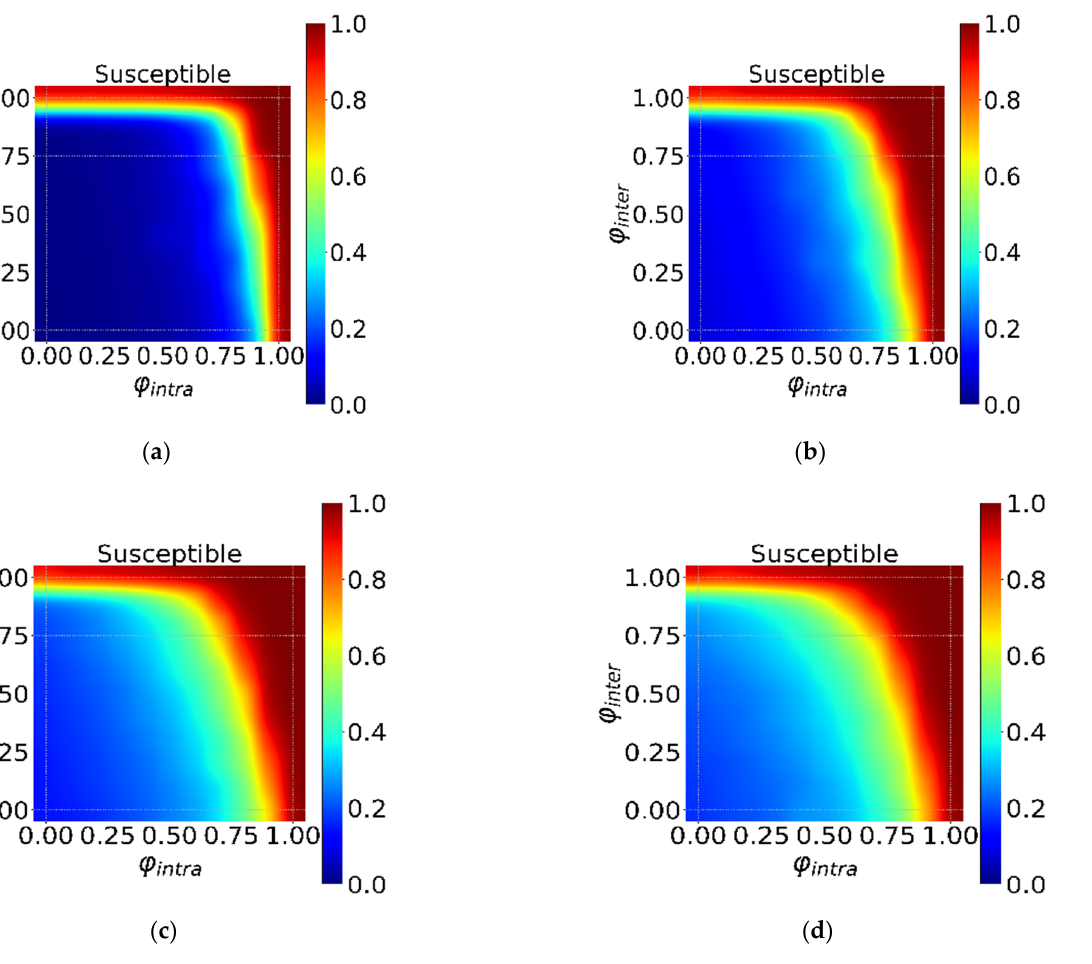
( f ) Figure 6. The interaction effect of the (cid:2030) (cid:3036)(cid:3041)(cid:3047)(cid:3045)(cid:3028) and (cid:2030) (cid:3036)(cid:3041)(cid:3047)(cid:3032)(cid:3045) under (cid:2028) (cid:3036)(cid:3041)(cid:3047)(cid:3045)(cid:3028) = (cid:2028) (cid:3036)(cid:3041)(cid:3047)(cid:3032)(cid:3045) = 0 . The horizontal axis is (cid:2030) (cid:3036)(cid:3041)(cid:3047)(cid:3045)(cid:3028) , and the vertical axis is (cid:2030) (cid:3036)(cid:3041)(cid:3047)(cid:3032)(cid:3045) in ( a – f ). Different colors in the heatmap indicate different S . The ratio from dark red to dark blue transitions from 1 to 0 in turn. ( a – f ) show the different incubation periods (cid:1831) (cid:3047) ( (cid:1831) (cid:3047) = 0, 5, 10, 15, 20, 25). ( a )